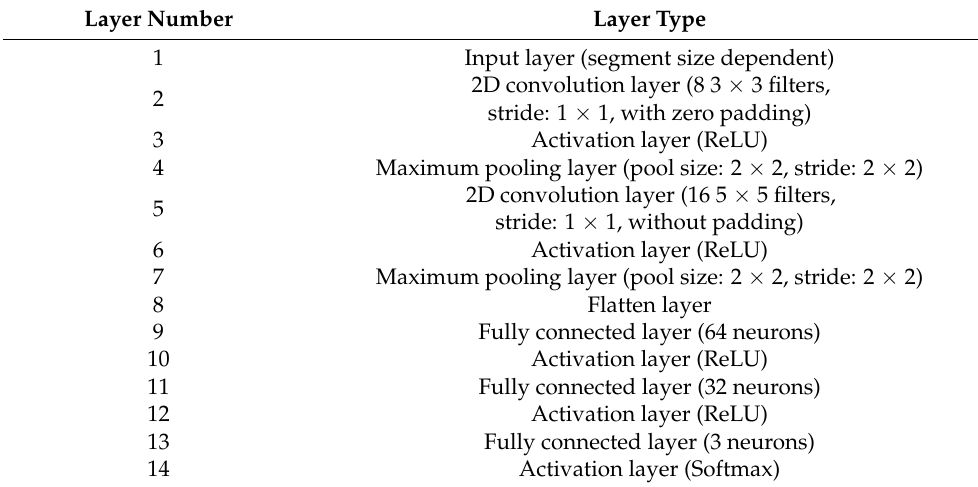
Table 4. CNN2 network